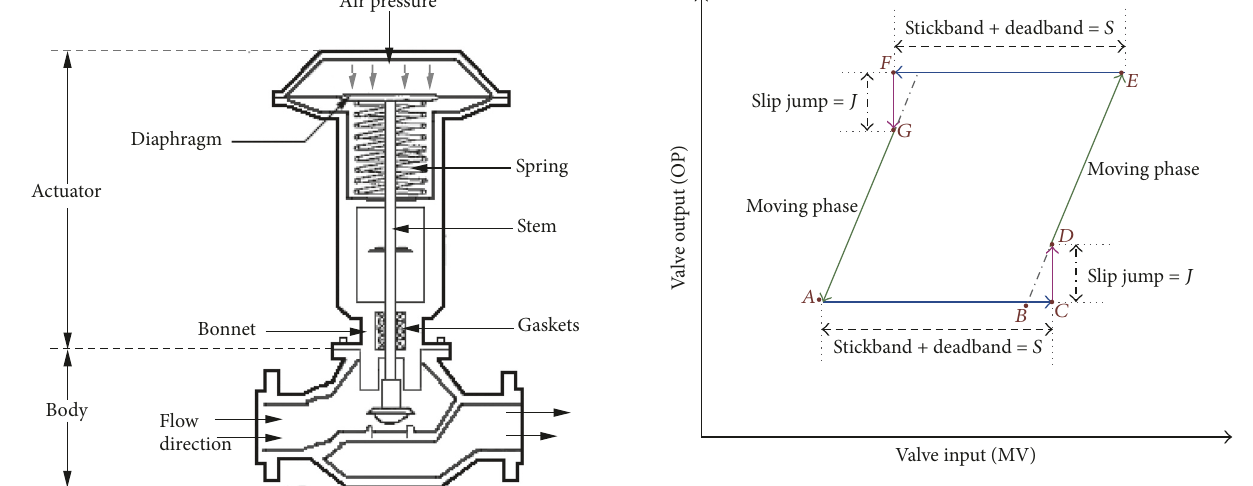
Figure 2: Standard signature curve of a valve with stiction (adapted from